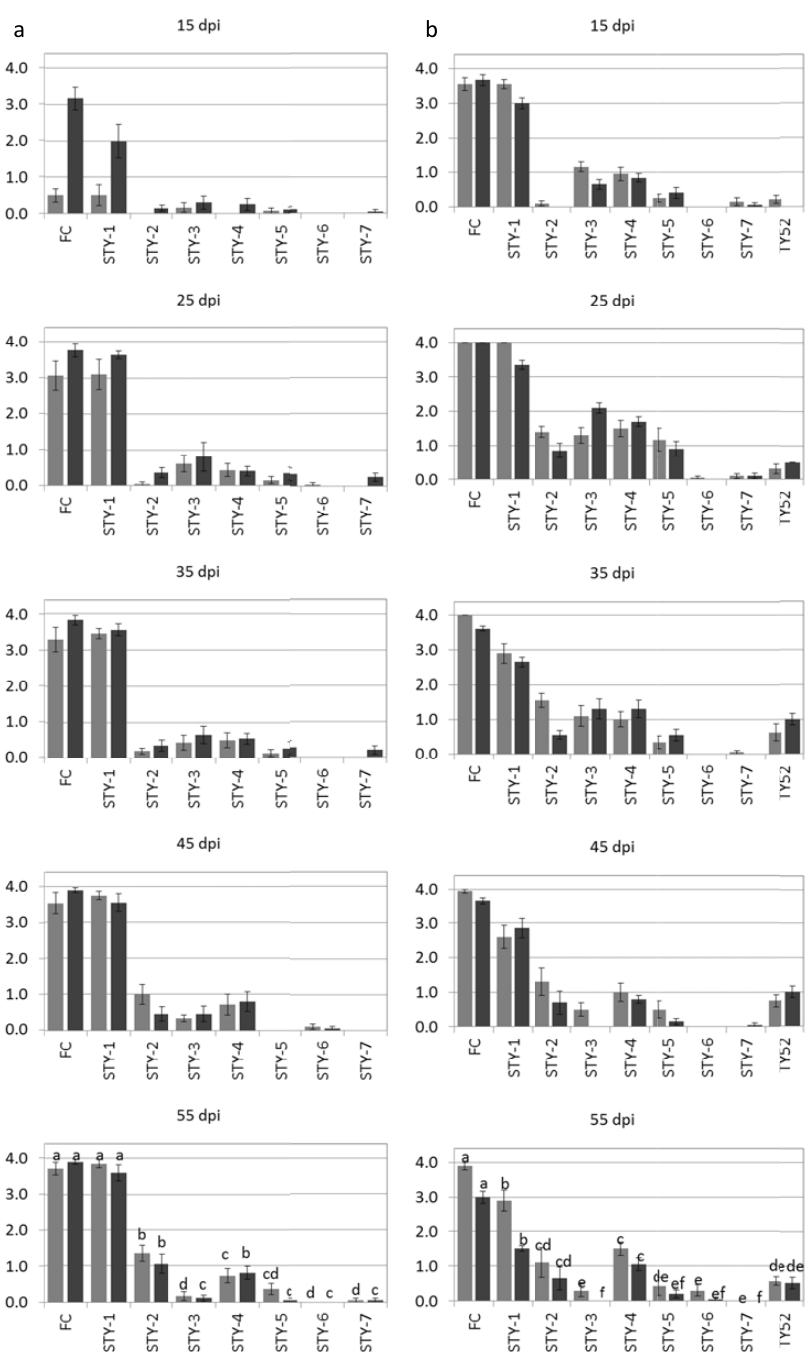
Figure 1. Average symptom score (± standard error) at each evaluation date (dpi: days post inoculation). Symptom scores were evaluated using a scale from 0 (symptomless) to 4 (severe symptoms). At 55 dpi, different letters for genotypes in the same assay indicate statistically significant differences (LSD, P <0.05). a) Assays 1 (light grey) and 2 (dark grey): STY lines and the susceptible control ‘Fortuna C’ (FC). b) Assays 3 (light grey) and 4 (dark grey): STY lines, the susceptible control ‘Fortuna C’ (FC) and the resistant control